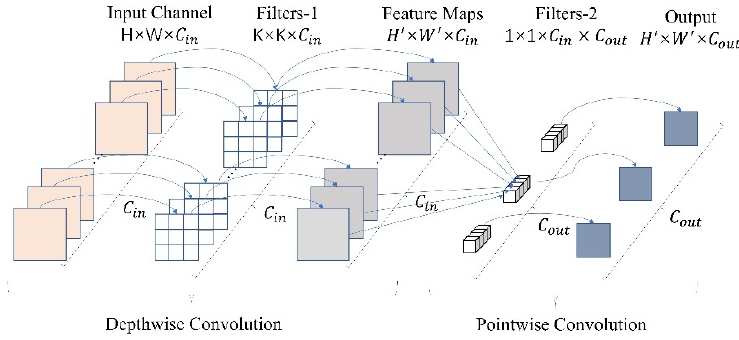
Figure 5. The depthwise separable convolution feature extraction process.